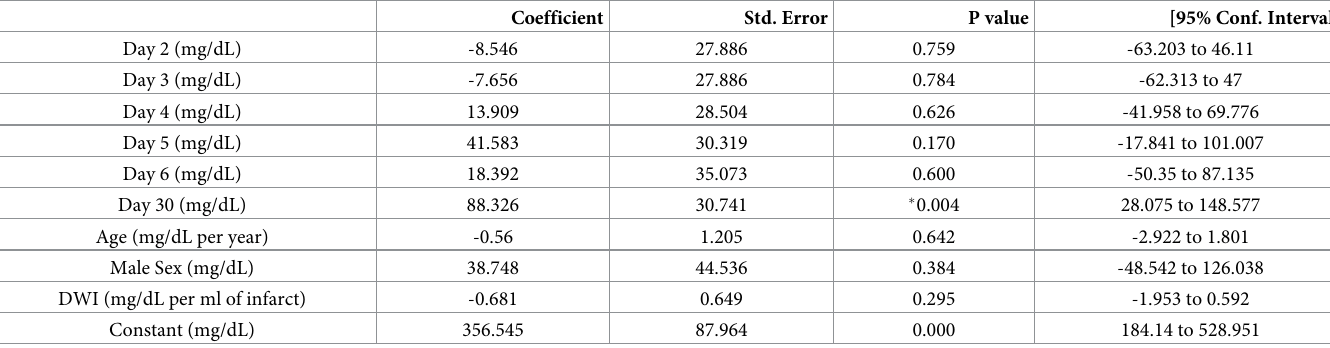
Table 3. Mixed model analysis for repeated measures of FRAP during follow up. � = significant. Coefficient Std. Error P value [95% Conf.